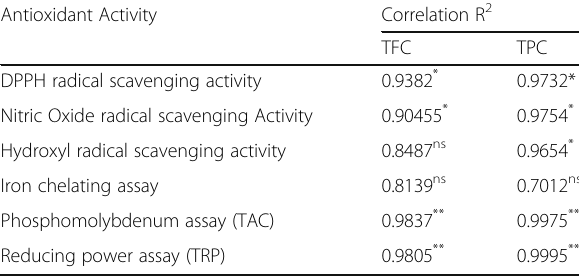
Table 2 Correlation of IC 50 values of different antioxidant activities of I. batatas with total phenolic and total flavonoid